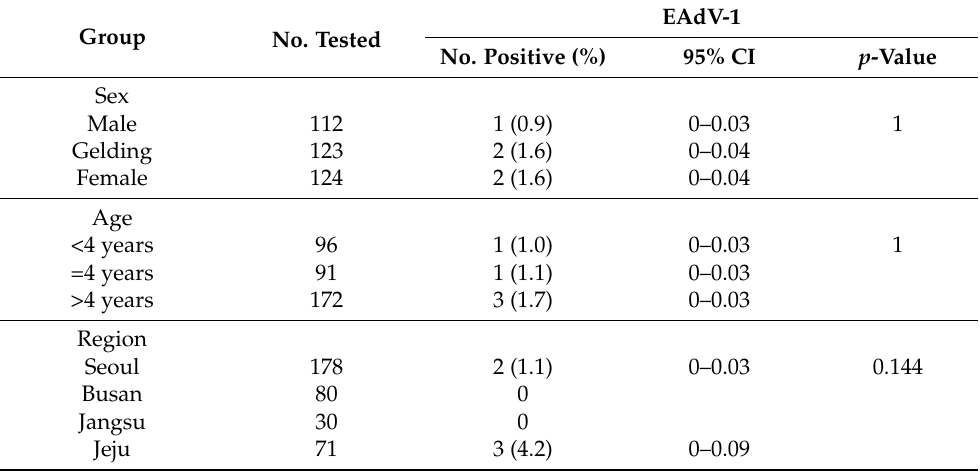
Table 1. Prevalence of EAdV-1 detected using a PCR on nasal swabs from horses at KRA facilities in the Republic of Korea in